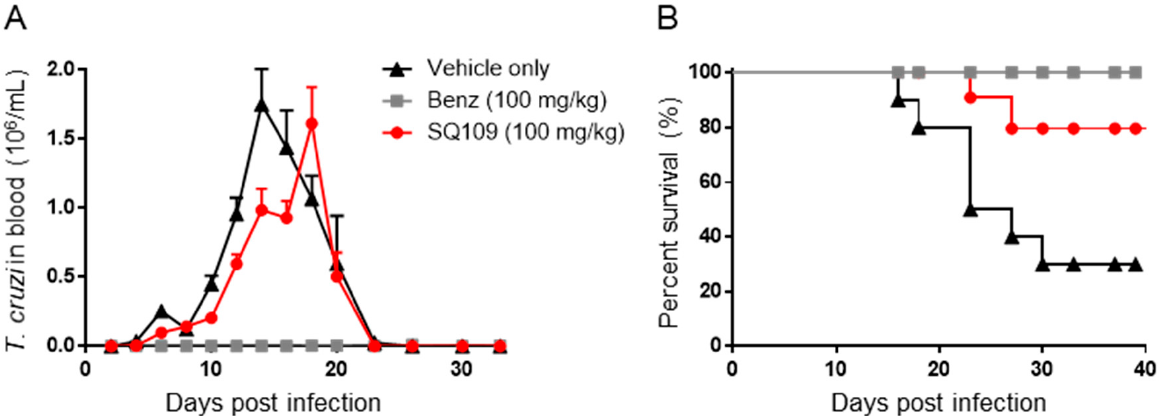
Figure 4. Efficacy of SQ109 in acute T. cruzi mouse model. ( A ) Number of T. cruzi parasites in the bloodstream. ( B ) Survival of T. cruzi infected BALB/c mice. In vivo study of BALB/c mice infected with T. cruzi Dm28c . of vehicle only [ ▲ ], Benznidazole (100 mg/kg) [ ■ ], or SQ109 (100 mg/kg) [ ● ] treated BALB/c mice after infection of T. cruzi Dm28c. ( n = 10).